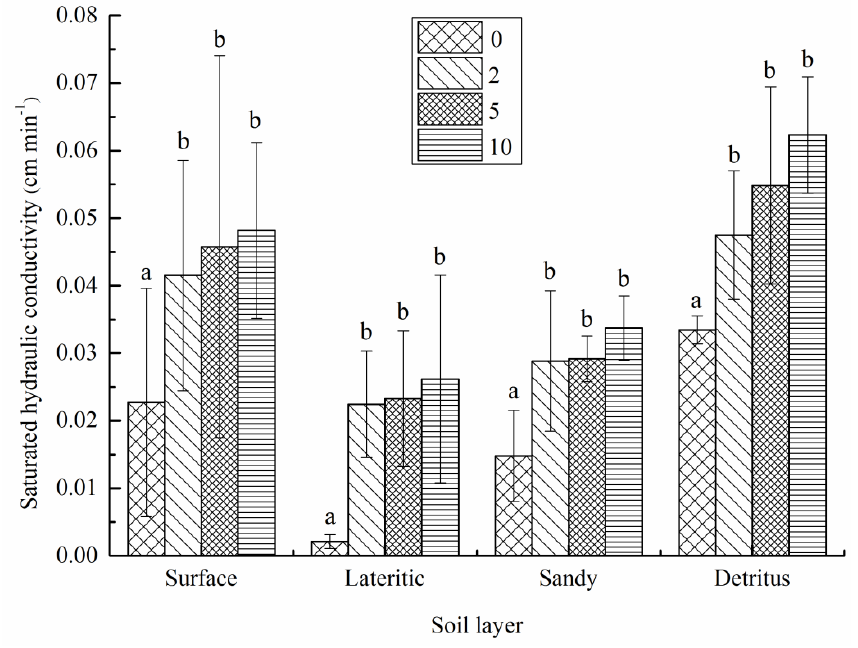
Figure 6. Saturated hydraulic conductivity of experimental soils. For the same soil layer, different letters (a – b) indicate significant differences ( p < 0.05) between different numbers of W-D cycles.